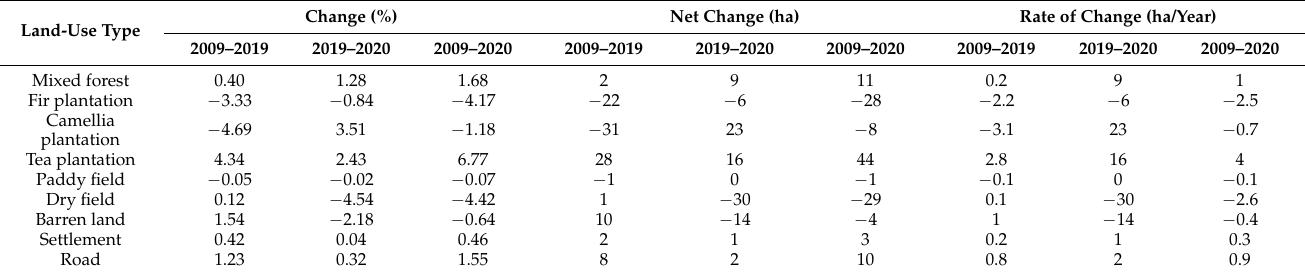
Table 7. Percentage change, net change and rate of change between 2009, 2019 and 2020 for the classified land-use categories.